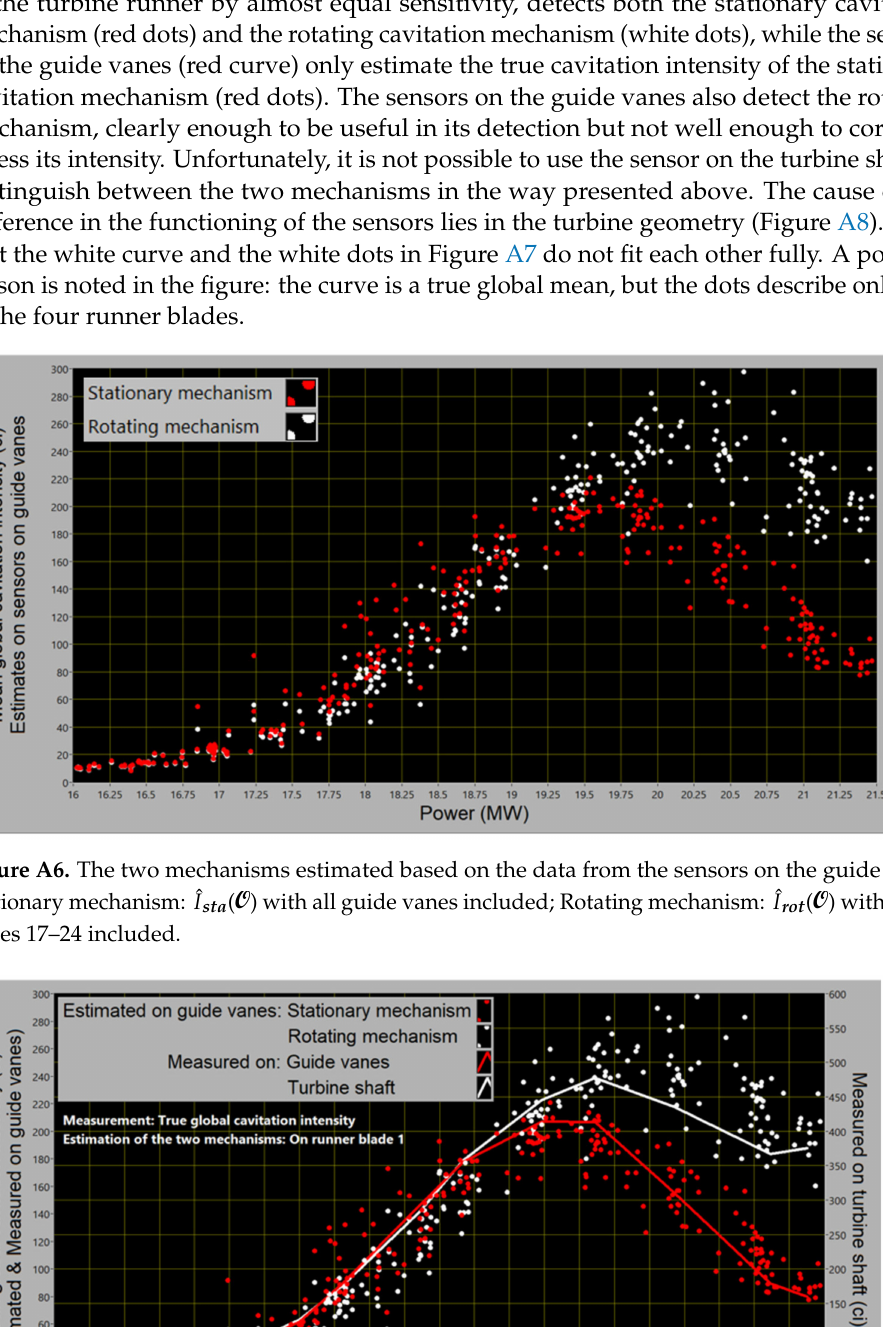
Figure 3. Front panel of the multidimensional data acquisition processor. The simplest description of cavitation comes out online after half an hour of measurement on the prototype. More compli- cated descriptions require days or weeks of recorded data analysis by a trained user.